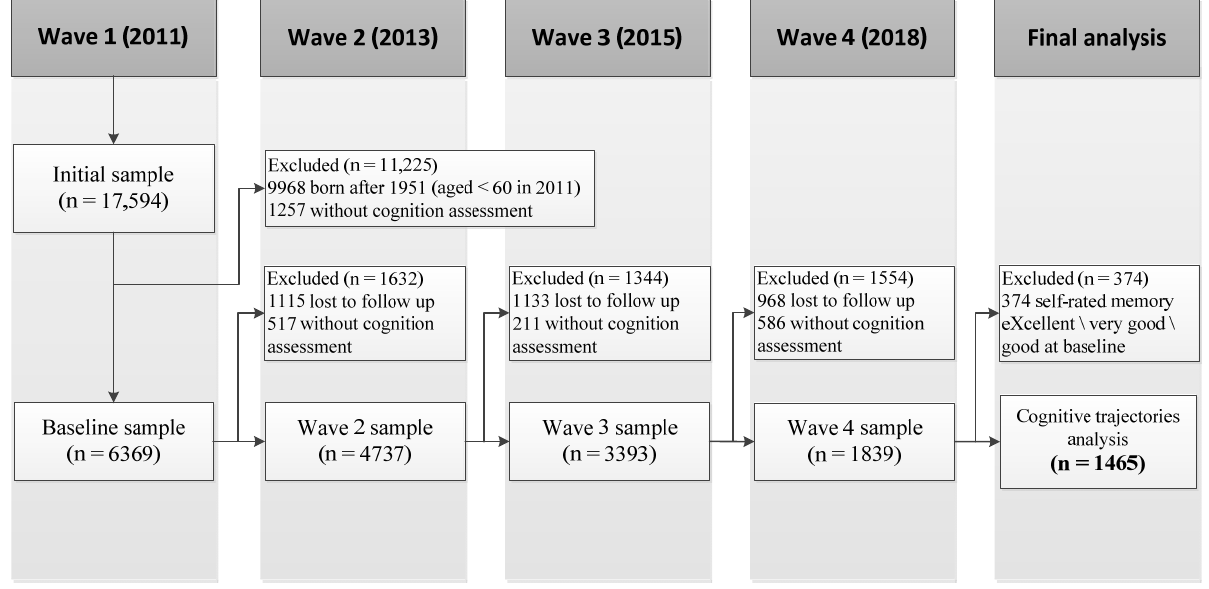
Figure 1. The flowchart of recruited participants for the analysis.